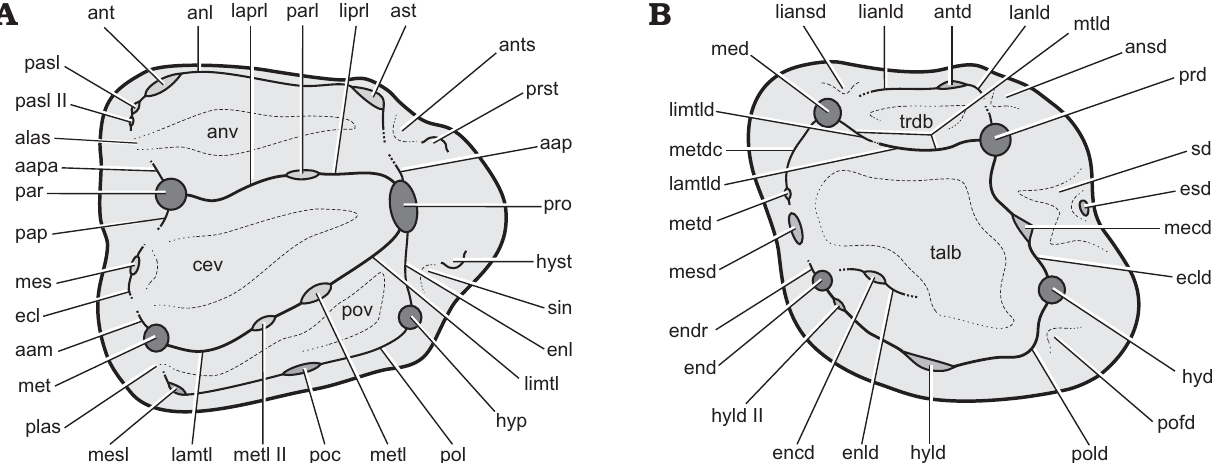
Fig. 2. Upper ( A ) and lower ( B ) sciurid cheek teeth illustrating the terminology employed here (after Marivaux et al. 2004; Comte et al. 2012; Vianey- Liaud et al. 2013; and Maridet et al. 2017; with modifications). Abbreviations: aam, anterior arm of metacone (premetacrista sensu Comte et al. 2012; Vianey-Liaud et al. 2013); aap; anterior arm of protocone; aapa, anterior arm of paracone; alas, anterolabial sinus; anl, anteroloph; ansd, anterosi- nusid; ant, anterocone; ants, antesinus; ast, anterostyle; antd, anteroconulid; anv, anterior valley; cev, central valley; ecl, ectoloph; ecld, ectolophid; encd, entoconulid; end, entoconid; endr, entoconid ridge; enl, endoloph; enld, entolophid; esd, ectostylid; hyd, hypoconid; hyld, hypoconulid; hyld II, hypoconulid II (second hypoconulid); hyp, hypocone (hypostyle sensu Popova 2016); hyst, hypostyle (hypostyle 2 sensu Popova 2016); lamtl, labial metaloph; lamtld, labial metalophid; lanld, labial anterolophid; laprl, labial protoloph; lianld, lingual anterolophid; liansd, lingual anterosinusid; limtl, lingual metaloph; limtld, lingual metalophid; liprl, lingual protoloph; mecd, mesoconid; med, metaconid; mes, mesostyle; mesd, mesostylid; mesl, meta- style; met, metacone; metd, metastylid; metdtc, metastylid crest; metl, metaconule; metl II, metaconule II (second metaconule); mtld, metalophid; pap, posterior arm of paracone (postparacrista sensu Comte et al. 2012; Vianey-Liaud et al. 2013); par, paracone; parl, paraconule; pasl, parastyle; pasl II, parastyle II (second parastyle); plas, posterolabial sinus; poc, posterocone; pofd, postflexid; pol, posteroloph; pold, posterolophid; pov, posterior